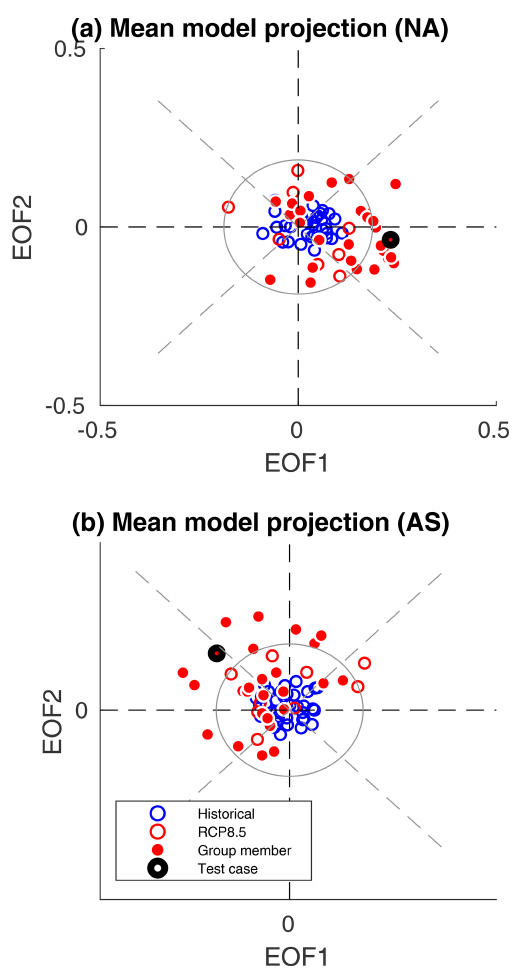
Figure 6. Mean location of every model on the (a) EOF NA and (b) EOF AS phase space. Each blue (red) marker represents the mean projection score of all historical (RCP8.5) DJF months. Filled cir- cles are models that were classified in the preferably phased groups, with a score bigger than 1 σ (denoted by the gray circle). High- lighted markers show the two GCMs chosen as test cases for daily data